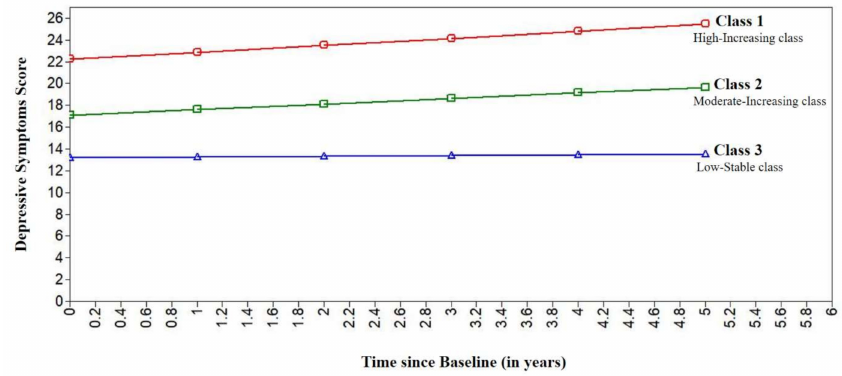
Figure 1. Latent classes of depressive symptom trajectories.